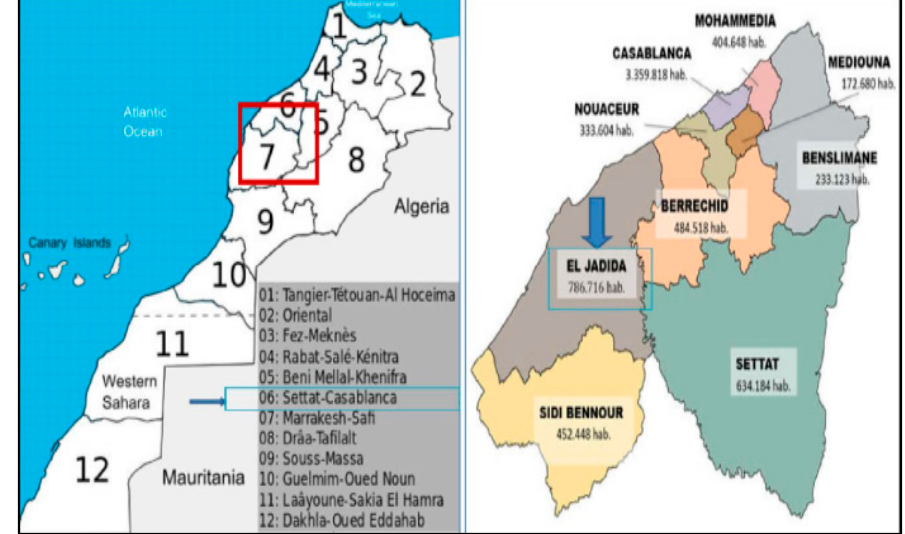
Figure 1. Map showing the geographical location of El Jadida province.